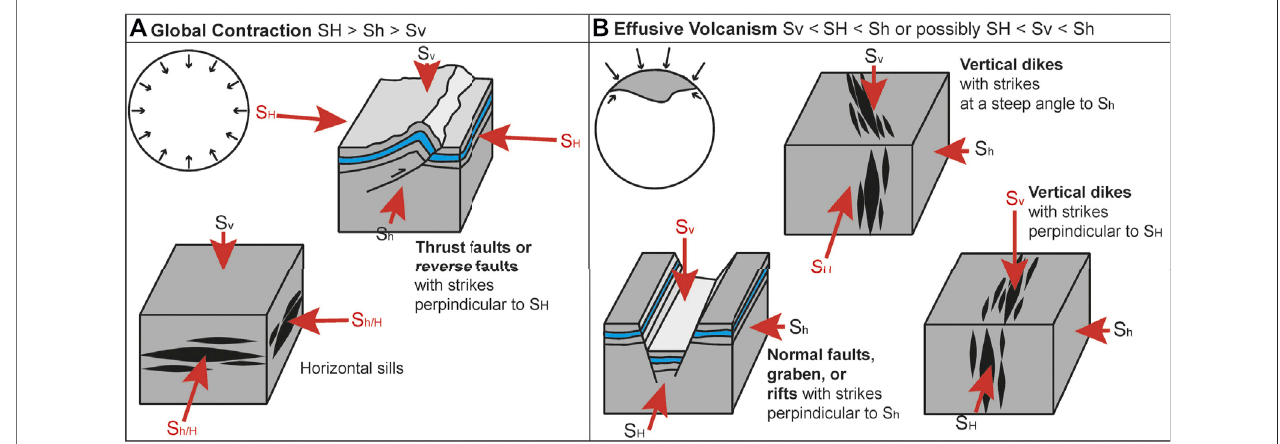
FIGURE 1| This fi gure illustrates the expected landforms from stress regimesassociated with global contraction and effusive volcanism. (A) Agloballycontracting lithosphereisexpectedtoproducemaximumhorizontalstressesandminimumverticalstressesthatpromotetheformationofthrustfaultsandhorizontalsills(Anderson, 1905). (B) Effusive volcanism is facilitated by minimum horizontal stresses (Anderson, 1951), which when combined with maximum vertical stresses, also produce normal faults and graben (Anderson, 1905).